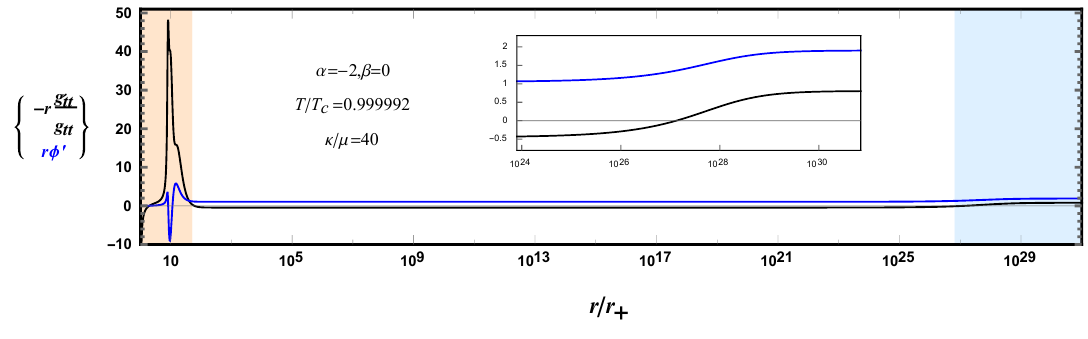
Figure 20 . Journey through the inside of the pure non-linear massive gravity black hole.